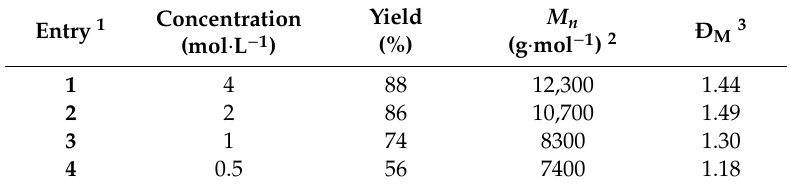
Table 1. E ff ect of monomer concentration on yield, M n and dispersity of poly(hexylene